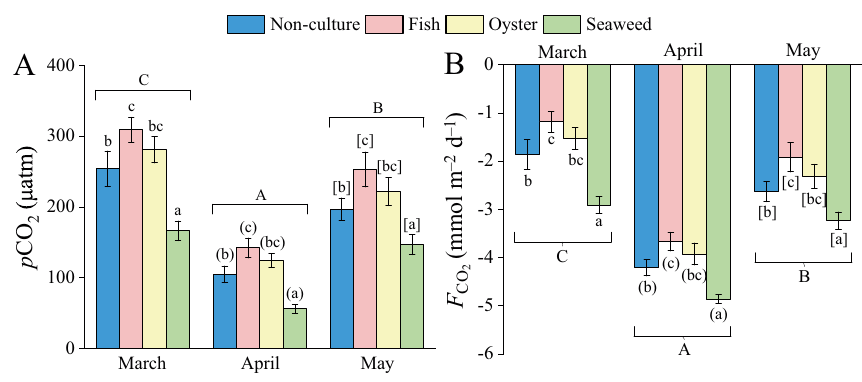
absorbing CO , but have almost no effect on TA 2